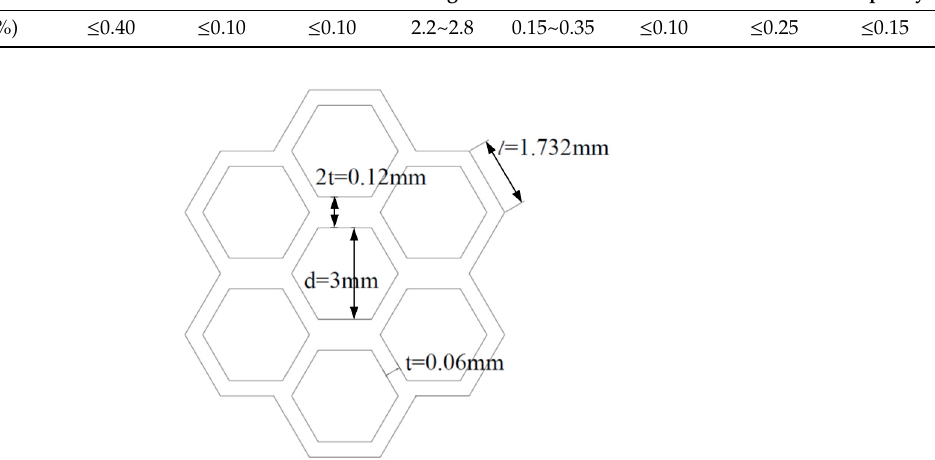
Figure 1. Cell characteristics of the aluminum honeycomb.